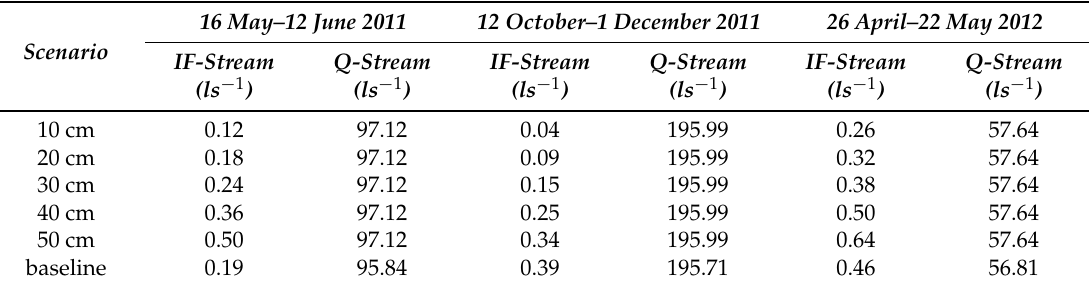
infiltration to the two ditches is considered for the